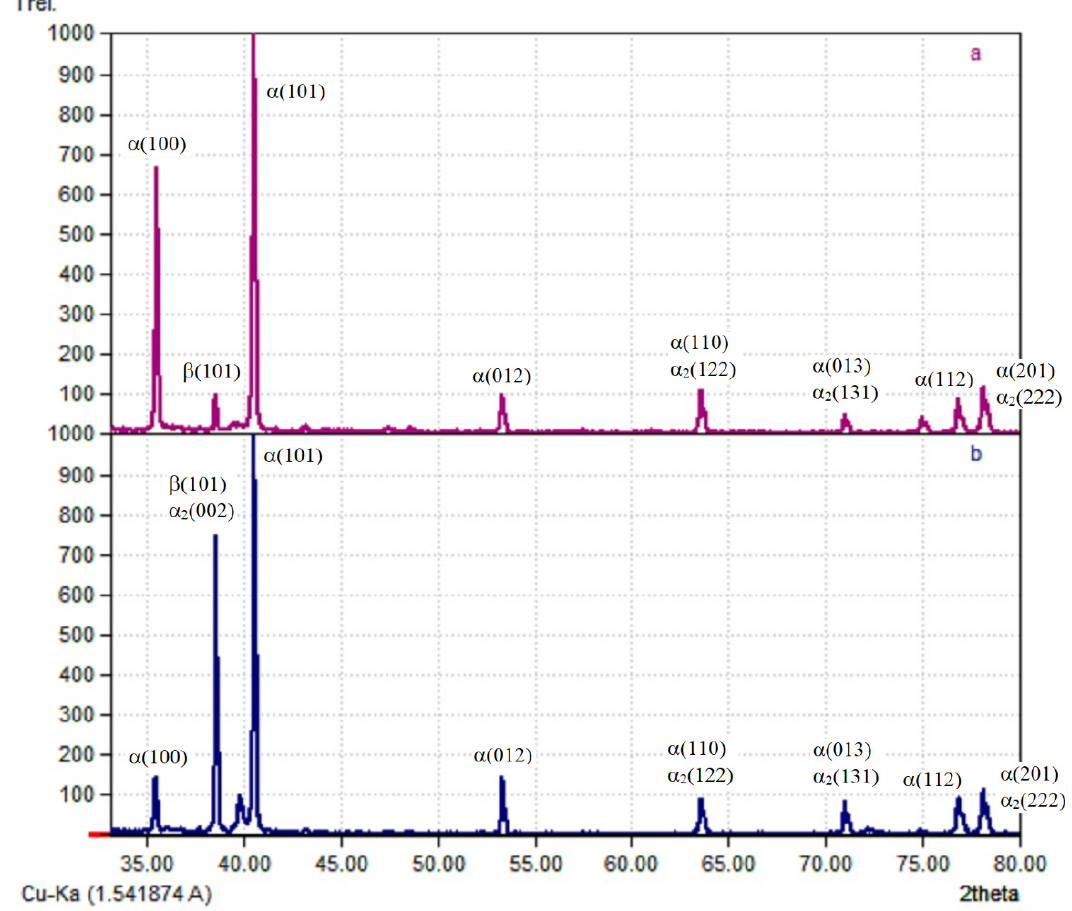
Figure 17. Diffraction patterns for specimens obtained using CMT deposition ( a ) and CMT deposition with forging ( b ) after heat treatment.